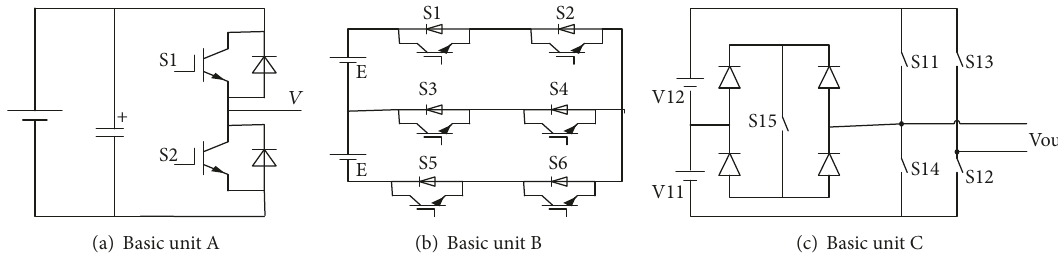
Figure 1: Basic unit of the